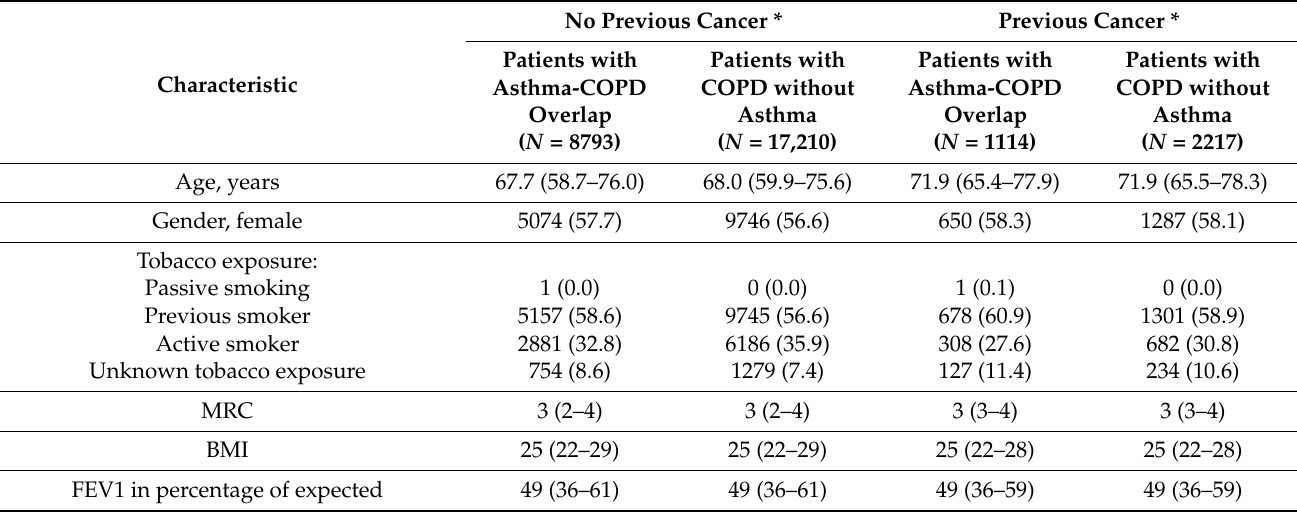
Table 1. Characteristics of propensity-matched groups of patients with asthma-COPD overlap and groups of patients with COPD without asthma.